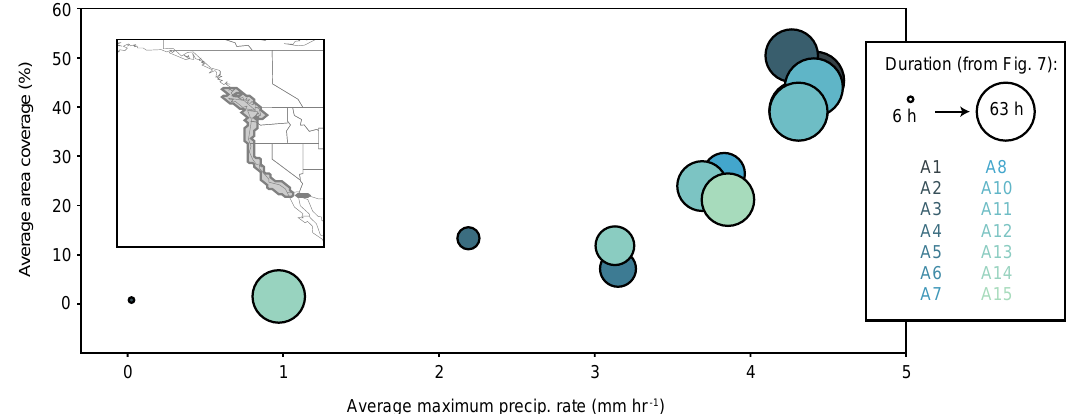
Figure 8. Focusing on the landfalling event in Fig. 7c, the average areal extent of the landfalling plume ( y axis) and average of the maximum precipitation rate at each detected time slice ( x axis) are compared for each algorithm. The size of the markers corresponds to the duration of the event as described in Fig.